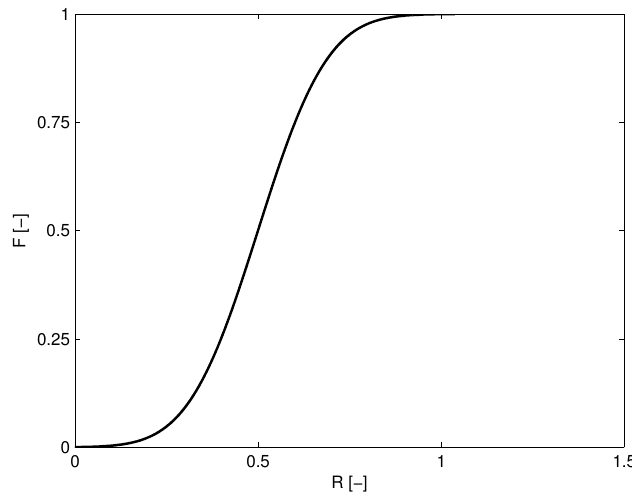
Figure 5. Transition parameter F depending on the extent of recrystallization R